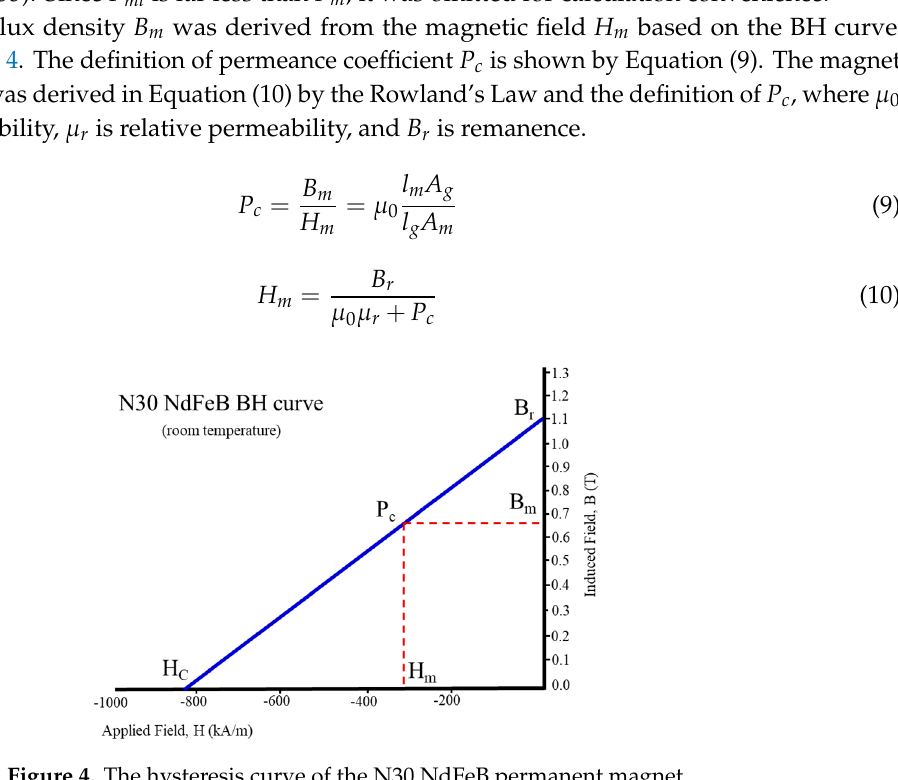
Figure 4. The hysteresis curve of the N30 NdFeB permanent magnet.